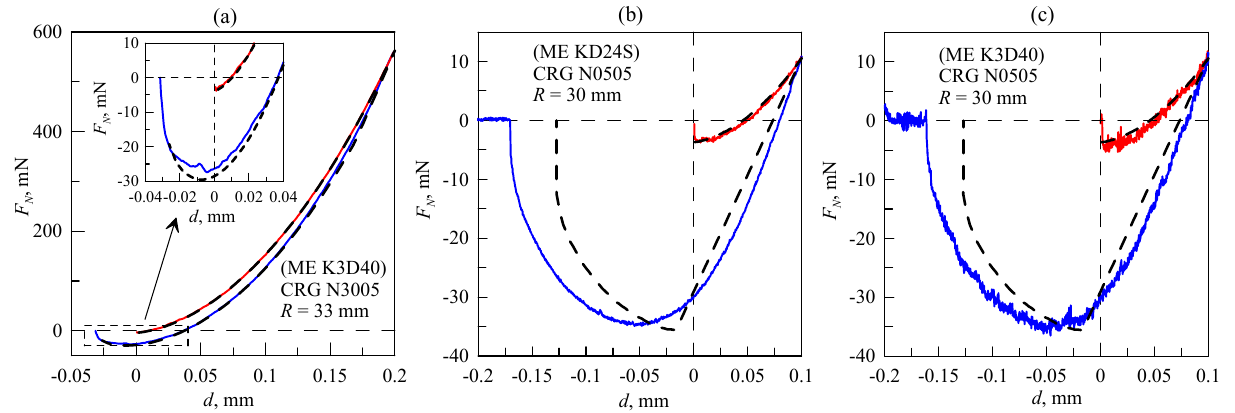
Figure 8. ( a – c ) Dependencies ( F N ( d )) obtained in experiments with the designed facility (solid lines) compared to numerical simulation (dashed lines) performed within the BEM model. Each panel shows a different experiment. Dependencies shown in panels ( b , c ) were measured under the same conditions with different force sensors.